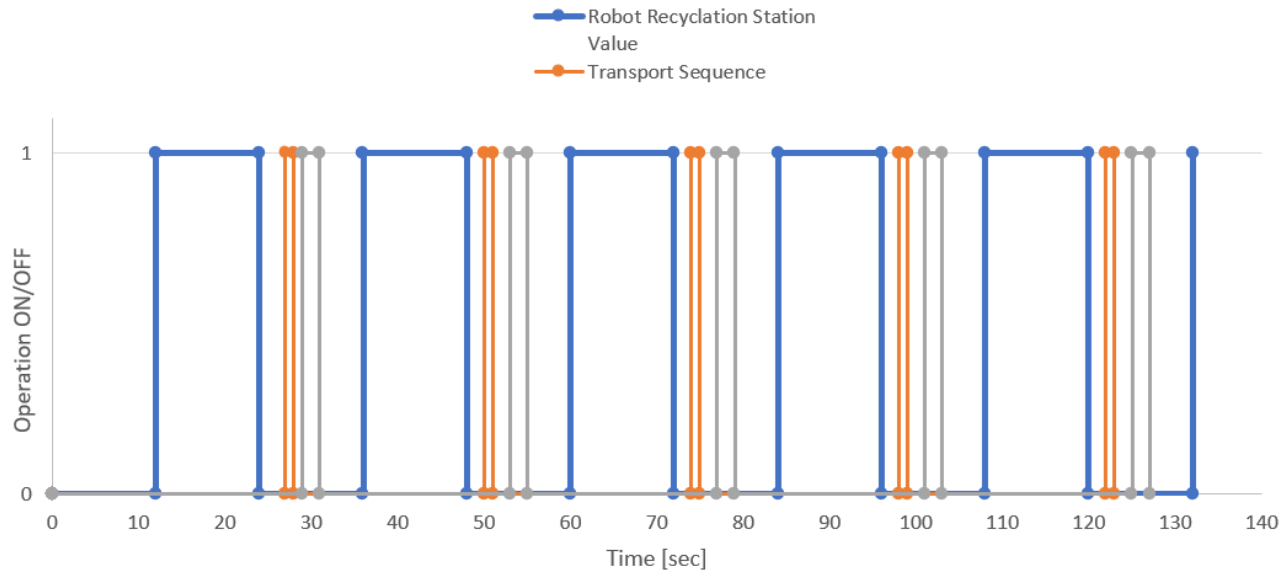
Figure 19. Length of operations of the production line components.